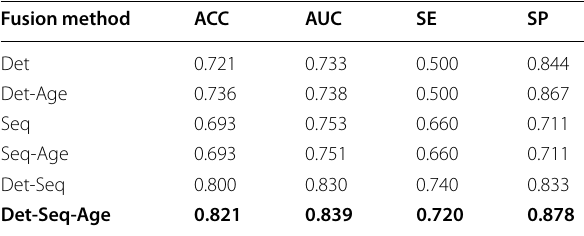
The bold highlight the relatively good results